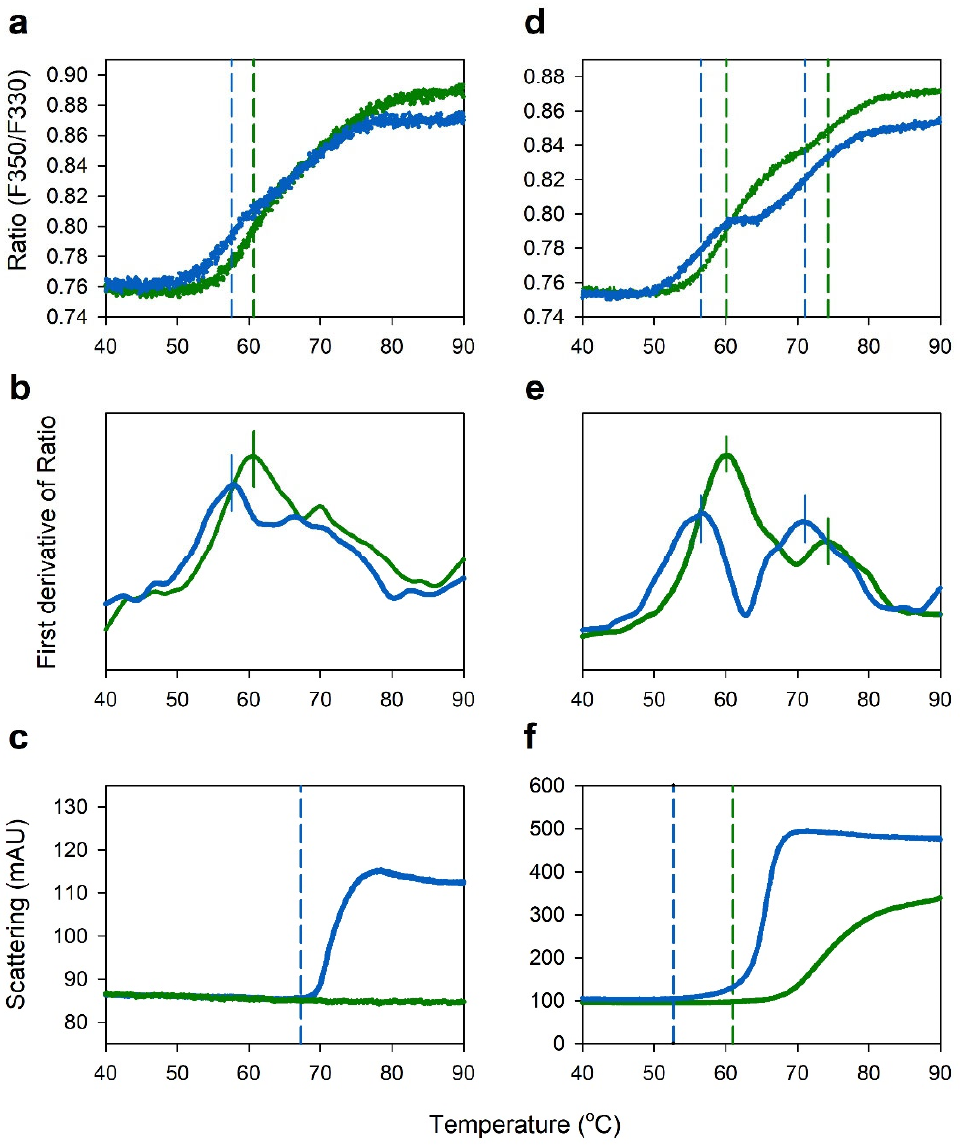
Figure 4. NanoDSF thermograms of IgGs at concentrations of 1 mg/mL ( a – c ) and 100 mg/mL ( d – f ) in acetate (green) and citrate buffers (blue) at the same pH 4.6. ( a,d) fluorescence intensity ratio (F350 nm/F330 nm); ( b , e ) first derivative of fluorescence intensity ratio; ( c , f ) light scattering ther ‐ mograms.